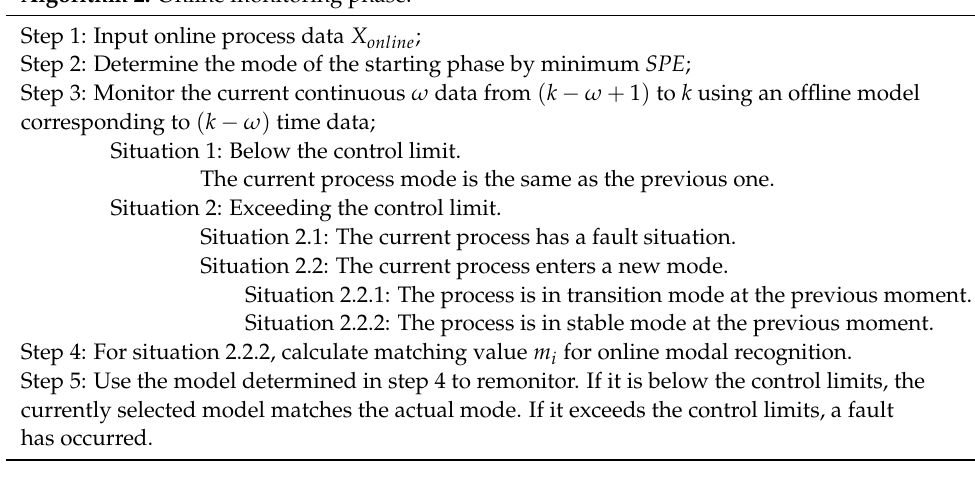
Algorithm 2. Online monitoring